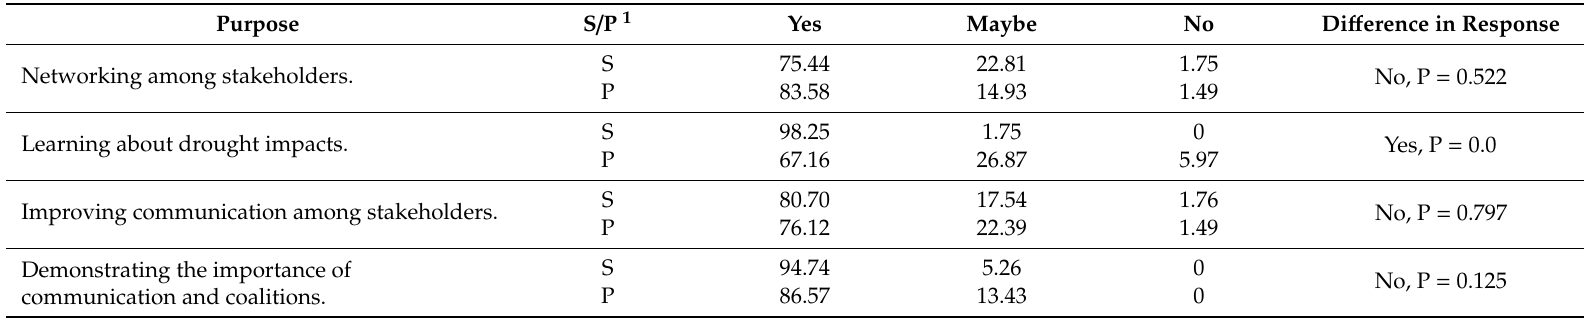
Table 3. Responses of the professionals (in percent of received responses) about the likelihood of various statements resulting from the game. Statement Very